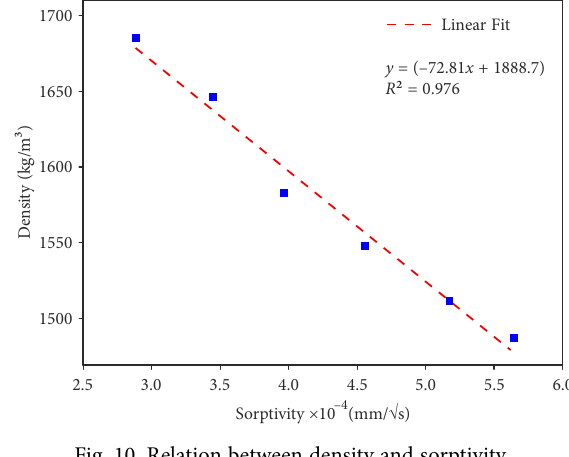
Fig. 10. Relation between density and